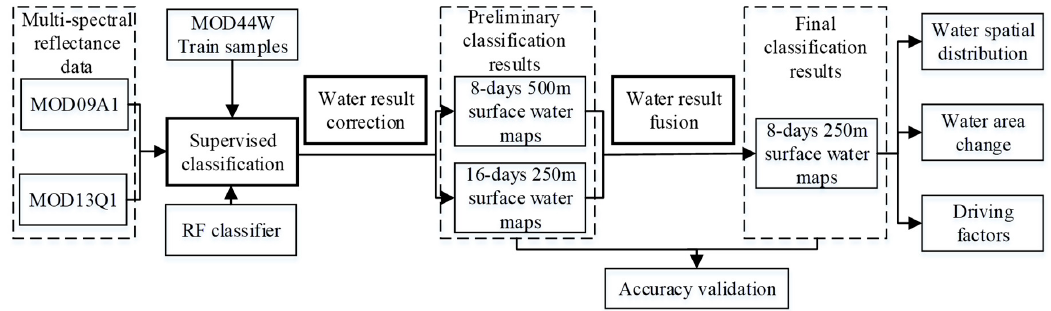
Figure 2. Overview of the acquisition and analysis of surface water results.